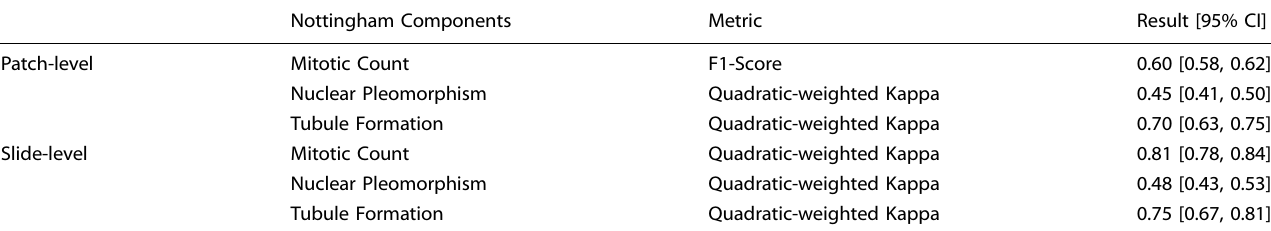
Table 2. Component model